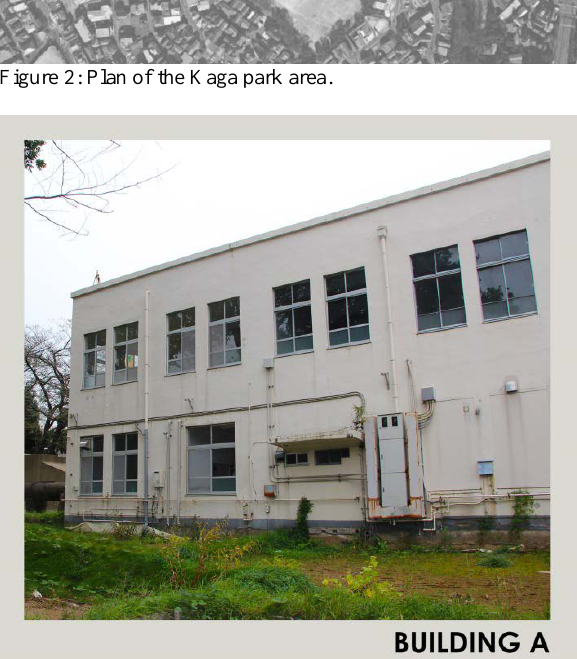
Figure 3: Building case of study (A).